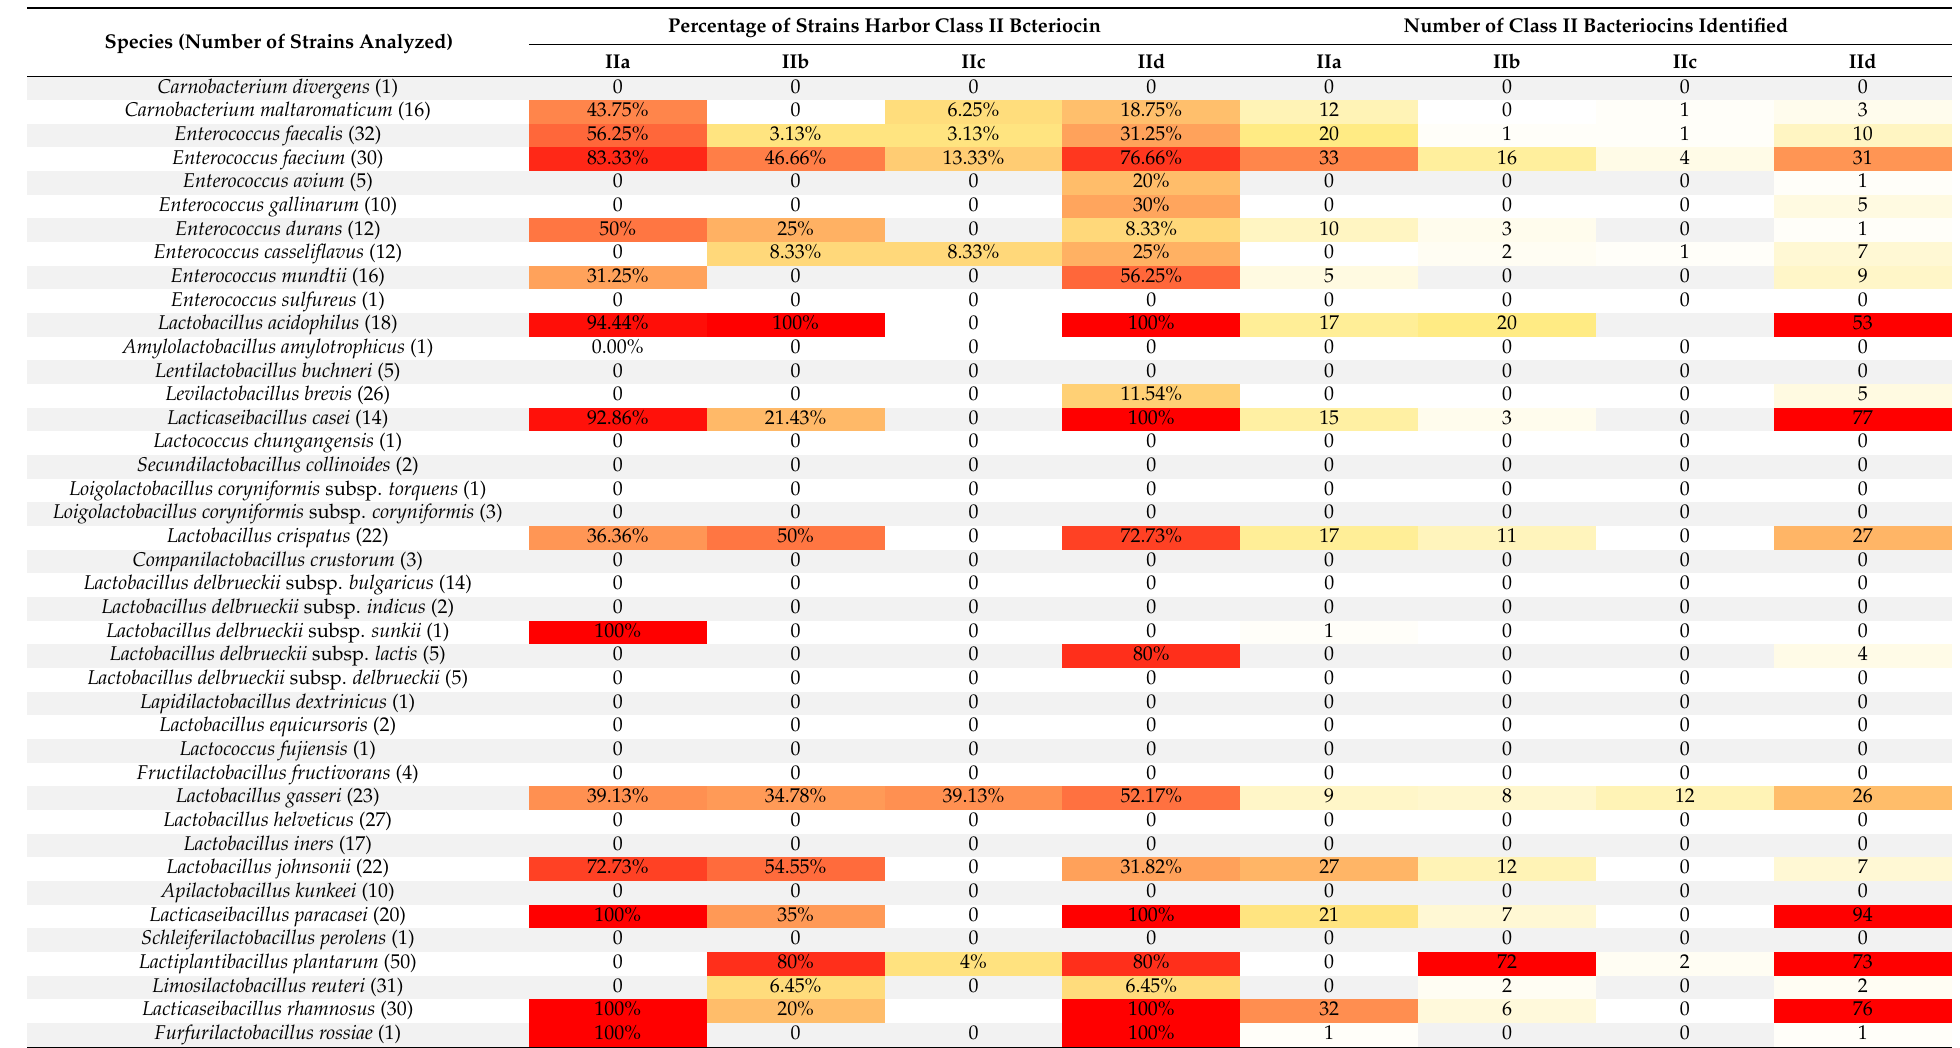
Table 3. Distribution of class II bacteriocin in some food associated